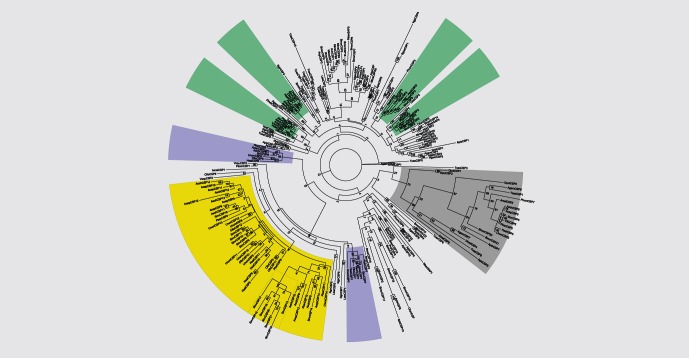
Arthropod CSP phylogeny.Maximum likelihood tree constructed from representative arthropod CSP protein sequences. Species are referred to in three letter codes. Confidence values (1000 bootstraps) are indicated. Different CSP groups are highlighted in different colors. Typical CSPs are highlighted in green and CSPs with smaller binding pocket in purple. All 5-helical CSPs in arthropods form a single clade which is highlighted in grey. The ant-specific expansion is highlighted in yellow.